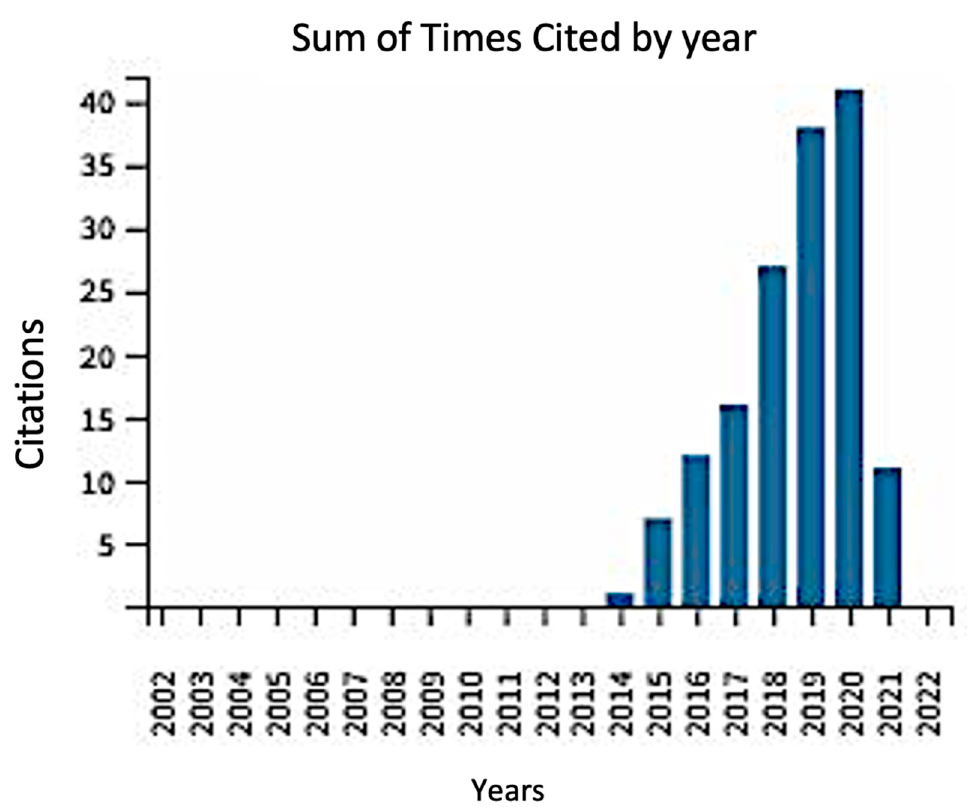
Figure 14. Citation report for 23 results from Web of Science Core Collection.